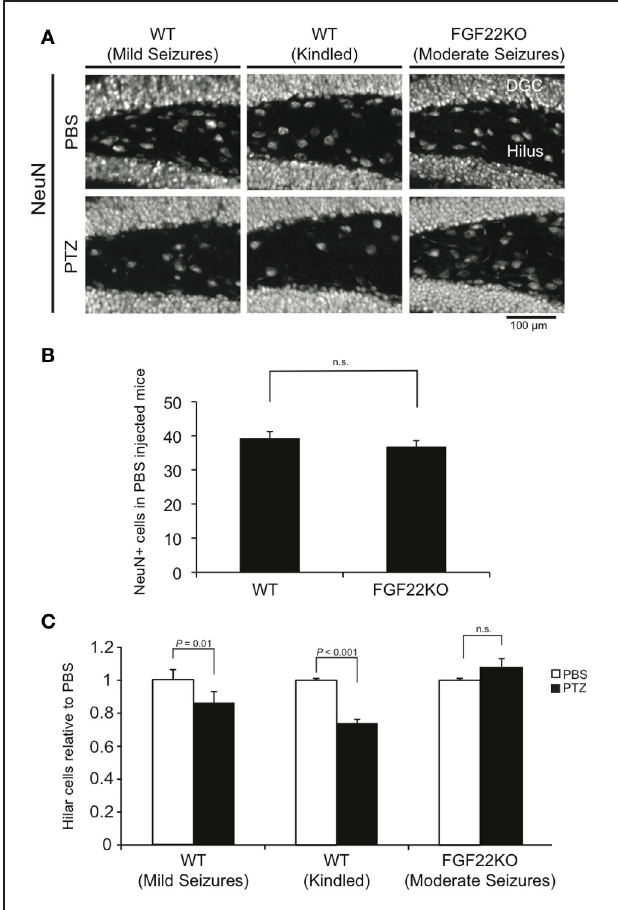
FIGURE 5 | Hilar cell death is increased in WT mice with mild and kindled seizures, but is unchanged in FGF22KO mice with moderate seizures. Region-matched sagittal hippocampal sections were prepared from PBS- and PTZ-injected WT and FGF22KO mice (3 groups of mice as shown in Figure 1 ) and stained for NeuN, a marker for mature neurons. (A) NeuN staining of the hilar sections from PBS- or PTZ-injected mice. (B) Quantification of the numbers of NeuN-positive cells in the hilus per section in PBS-injected WT and FGF22KO mice. (C) Quantification of the numbers of hilar cells. To evaluate hilar cell number, the number of hilar ectopic DGCs ( Figure 4 ) was subtracted from the number of NeuN-positive cells. Data are normalized relative to the corresponding PBS control. After PTZ injections, the number of hilar cells significantly decreased in WT mice both with mild and with kindled seizures, but not in FGF22KO mice with moderate seizures. Bars are mean ± s.e.m. P -values by Student’s t -test are indicated.